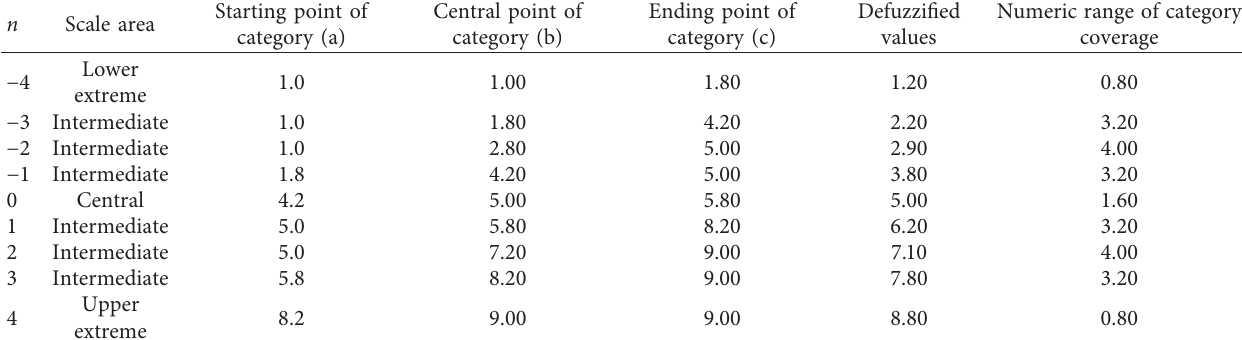
Table 3: Triangular fuzzy numbers of the 9-point fuzzy nonbalanced scale